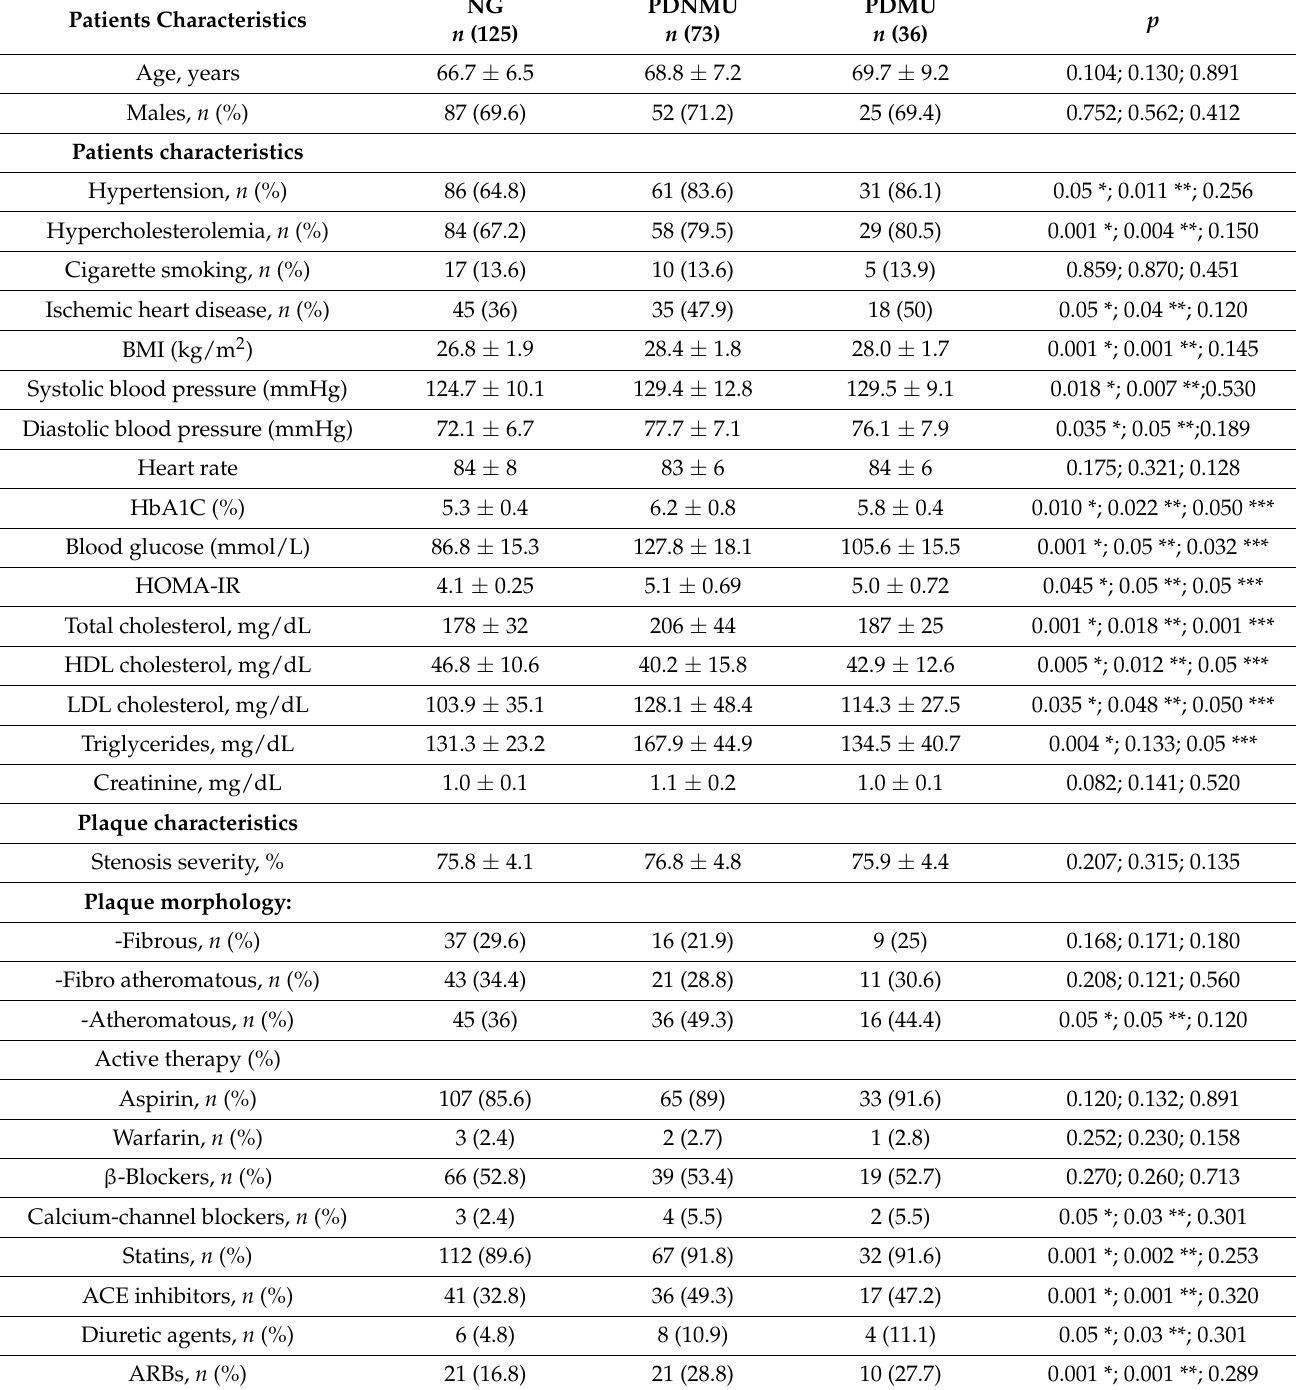
Table 1. Characteristics of study population at